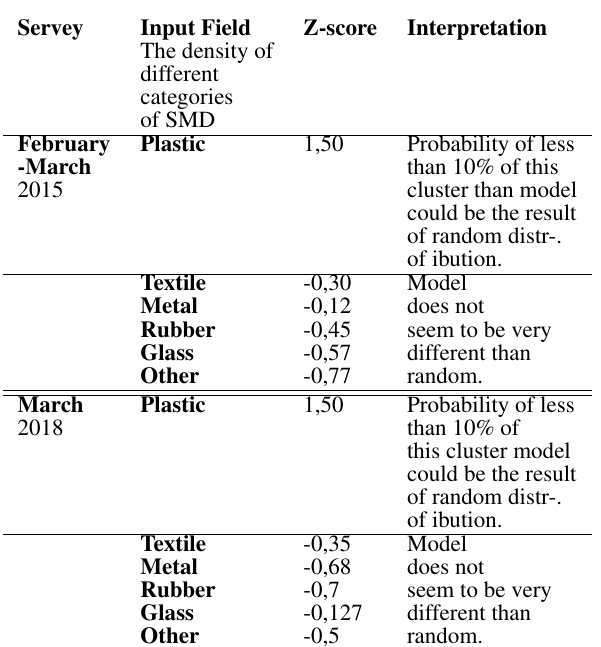
Table 1. The application of the index of spatial autocorrelation (Moran I) to all categories of SMD collected in the surveyed area in February-March 2015 and March 2018 surveys. The calculated Z-score indicates the statistical significance given the number of features in the dataset.